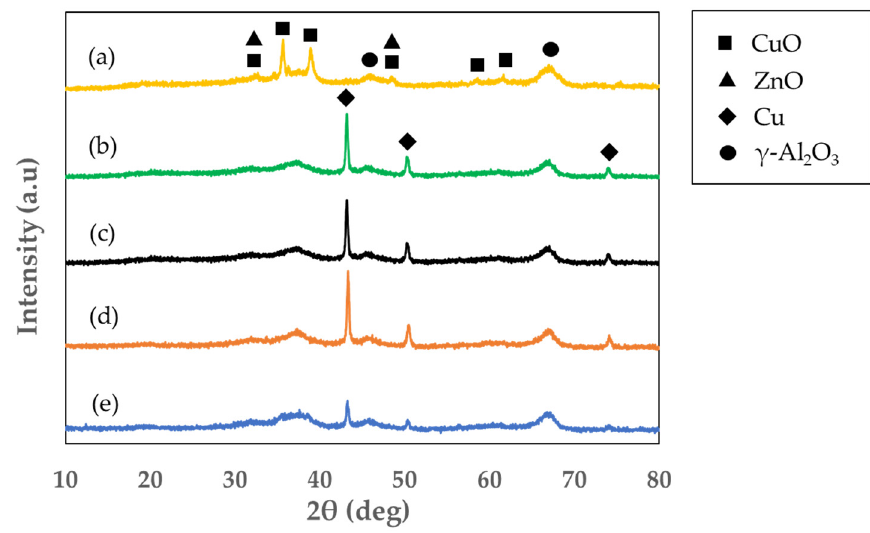
Figure 6. XRD patterns of CZMNZA catalyst of ( a ) fresh ( b ) 5 h ( c ) 2 days ( d ) 7 days and ( e ) 14 days